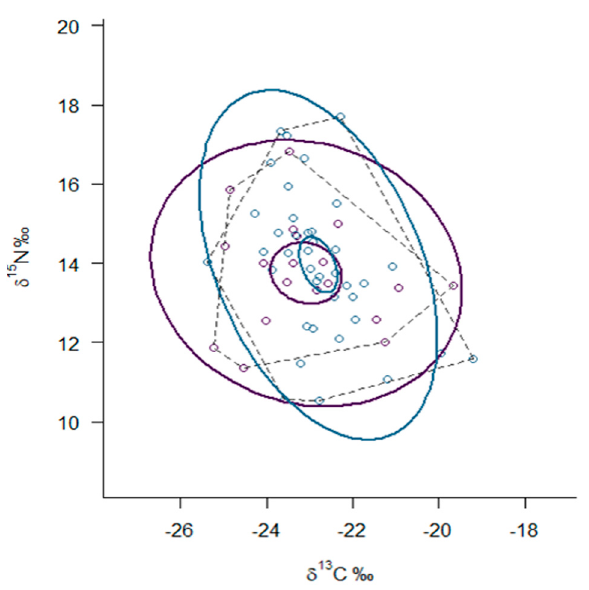
Figure 5. Stable isotope Bayesian ellipses (solid lines) represent the trophic niche width and overlap between the European mink (purple) and American mink (blue) based on standard ellipses corrected for small sample sizes (SEAc), with a 95% confidence interval for the means of each species. SEAc represents the core niche area of each group, while the convex hulls represent the overall niche diversity and encompass all data points. Each circle represents an individual mink.